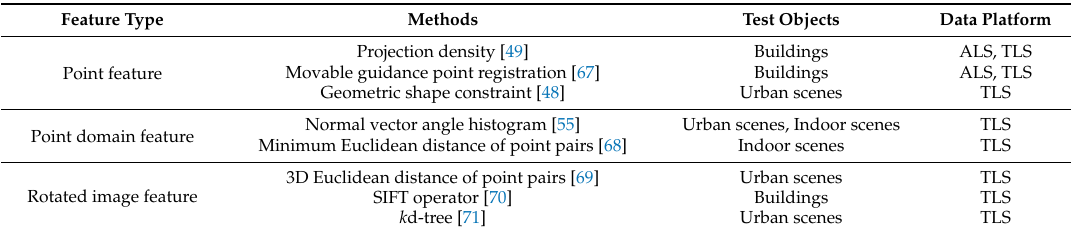
Table 2. Point-based registration methods for point